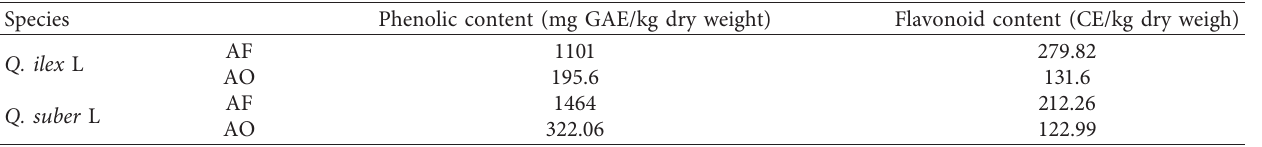
Table 6: Total phenolic content and total flavonoid content of acorn fruit oil and